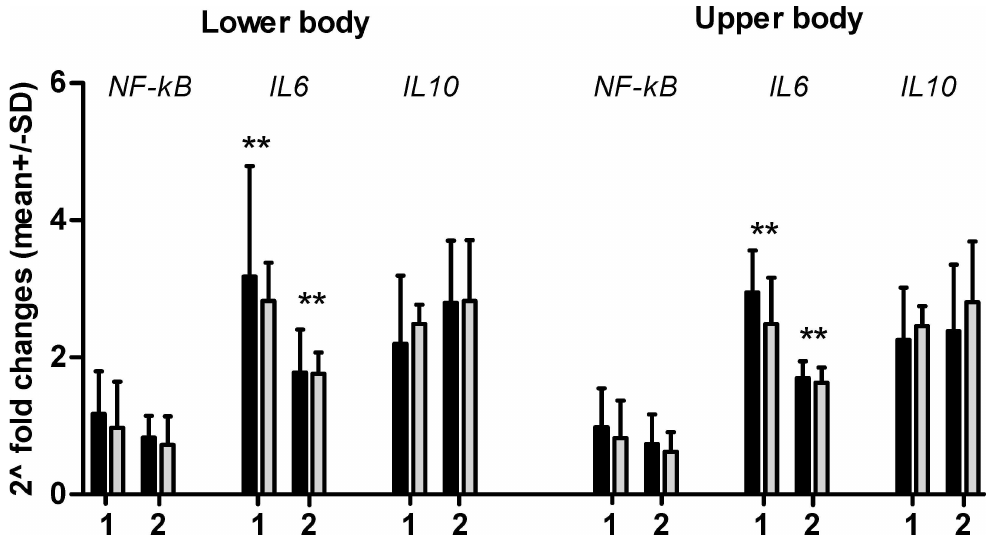
Fig 2. 2^FC in genes expressionafter lower and upper body exercisein EAG (gray bars) and PAM (dark bars). X-fold changeswere calculatedas